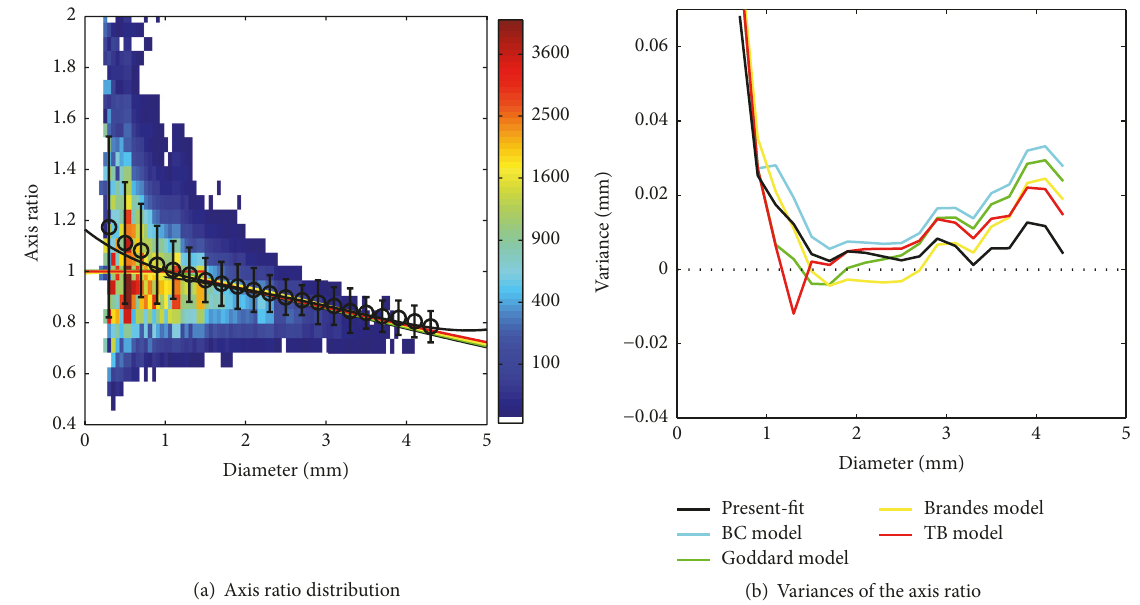
Figure 17: Comparison of the axis ratio distributions of raindrops from present result (black line), BC model (blue line), Goddard model (green line), Brandes model (yellow line), and TB model (red line).